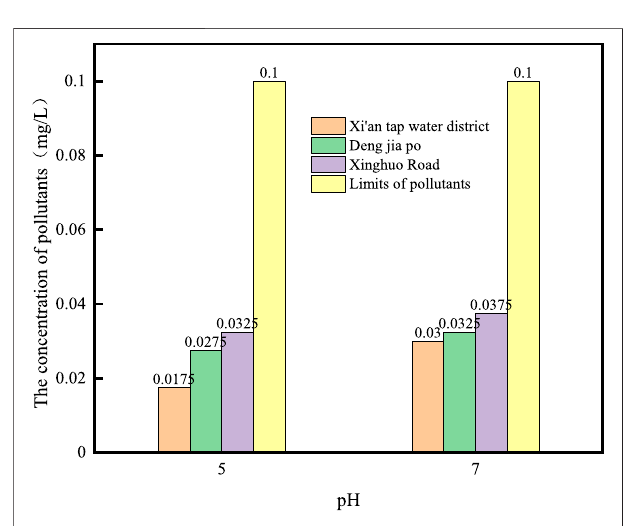
FIGURE 10 | Standard leaching results of Cr from recycled